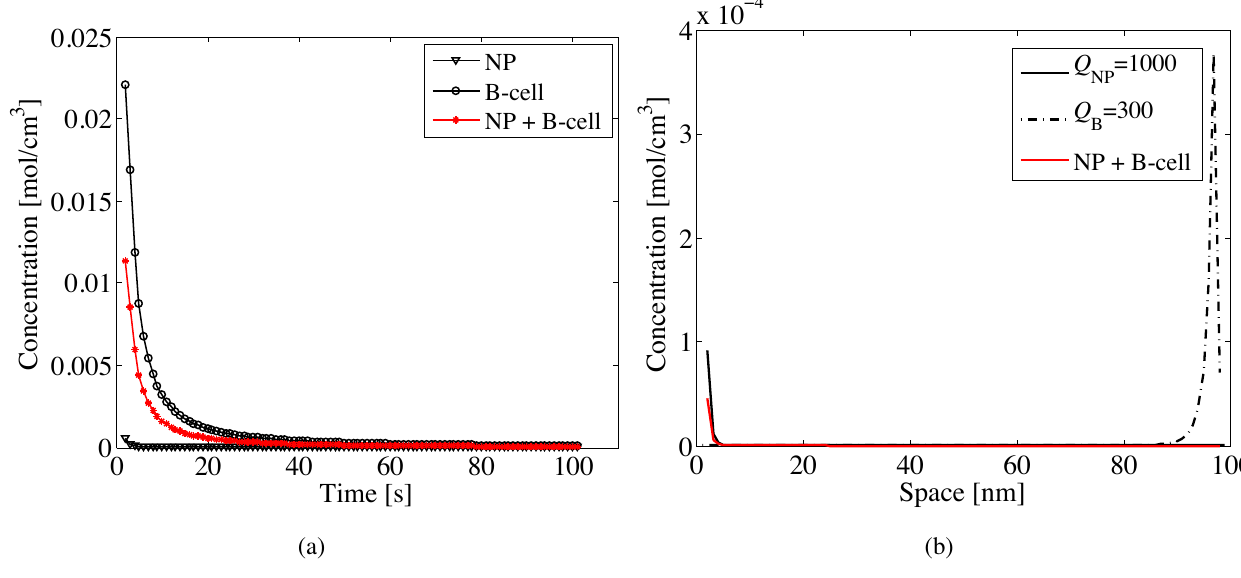
Figure 3. Variation of nanoparticle and B-cell concentrations vs . ( a ) time and ( b ) space for different values of initial concentrations, i.e. , Q